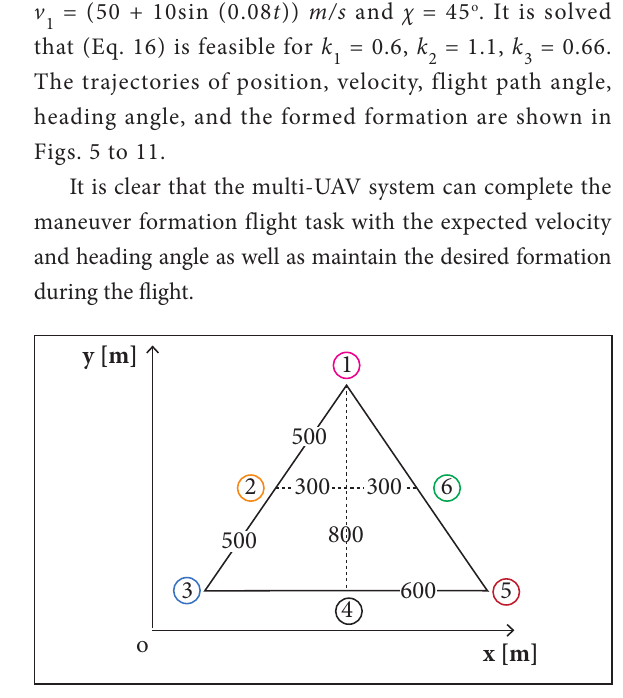
figure 4. Expected “triangle” formation diagram.